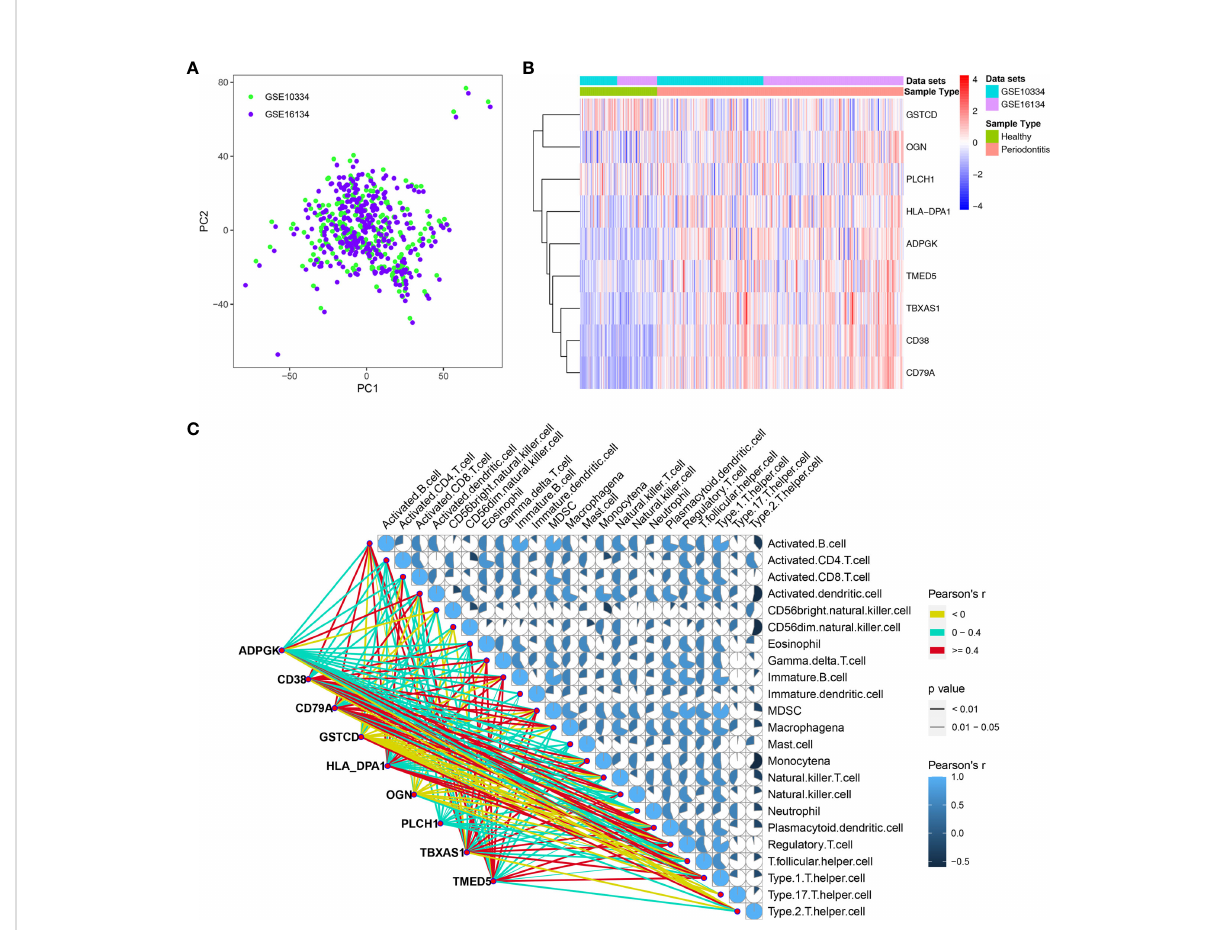
FIGURE 5 Dataset preprocessing and differential expression analysis of 9 hub DEGs. (A) The PCA plot displays removal batch effect between GSE10334 and GSE16134 cohorts. (B) Expression pro fi le of the 9 hub DEGs in the “ pooled ” dataset. (C) Expression of 9 hub DEGs correlated with the in fi ltration levels of various immune cells in periodontitis. The size and color of the pie chart were related to the correlation for the interaction of immune cells. The line color is related to the degree of correlation, and line size represents the p